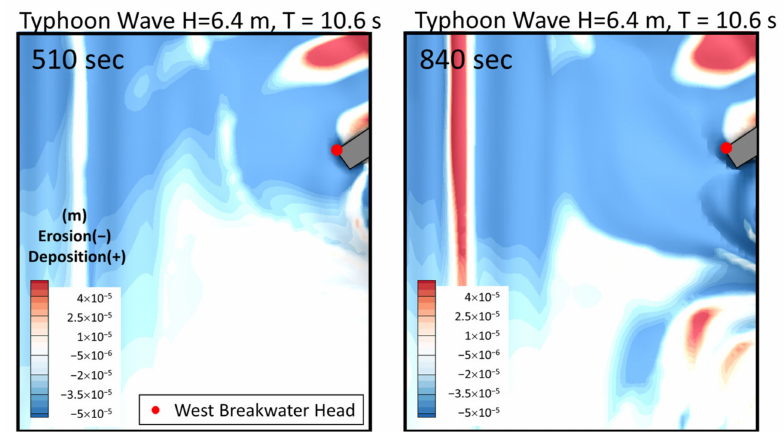
Figure 35. Topographic change at t = 510 s and 840 s.